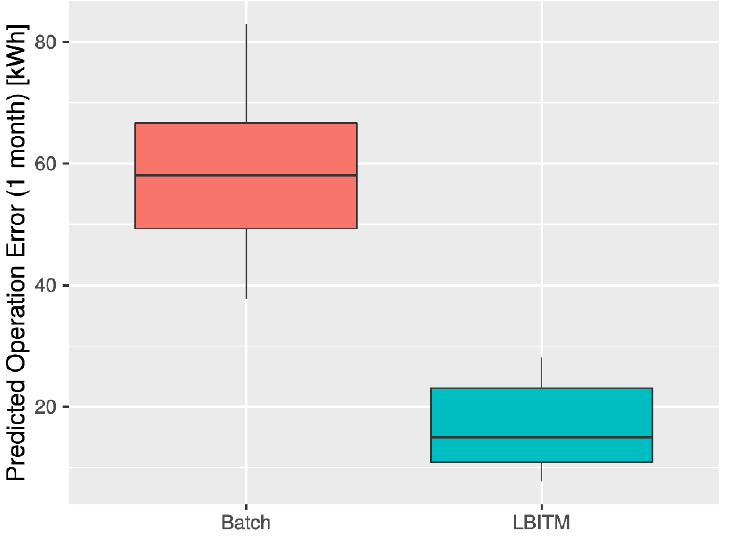
Figure 5. Errors on the prediction of operation for the batch estimation and the LBITM. The transition matrices were generated with 48 data points of the series that represent approximately a day of operation, and the obtained transition matrix was used to generate the forecasted operation in the two cases. The p -value when comparing both distributions with a t -test is <0.0001.